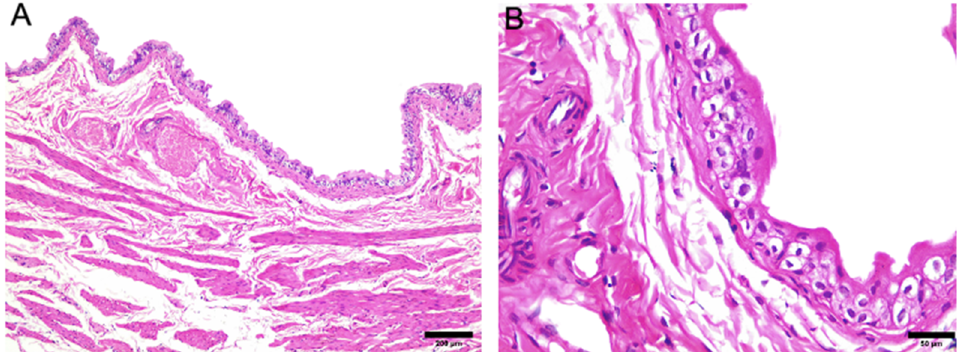
Figure 3. Histological photomicrographs of the urinary bladder tissue of rats in the control group show normal patterns of staining (hematoxylin-eosin staining)—( A ) HE—200 µm and ( B ) HE—20 µm.